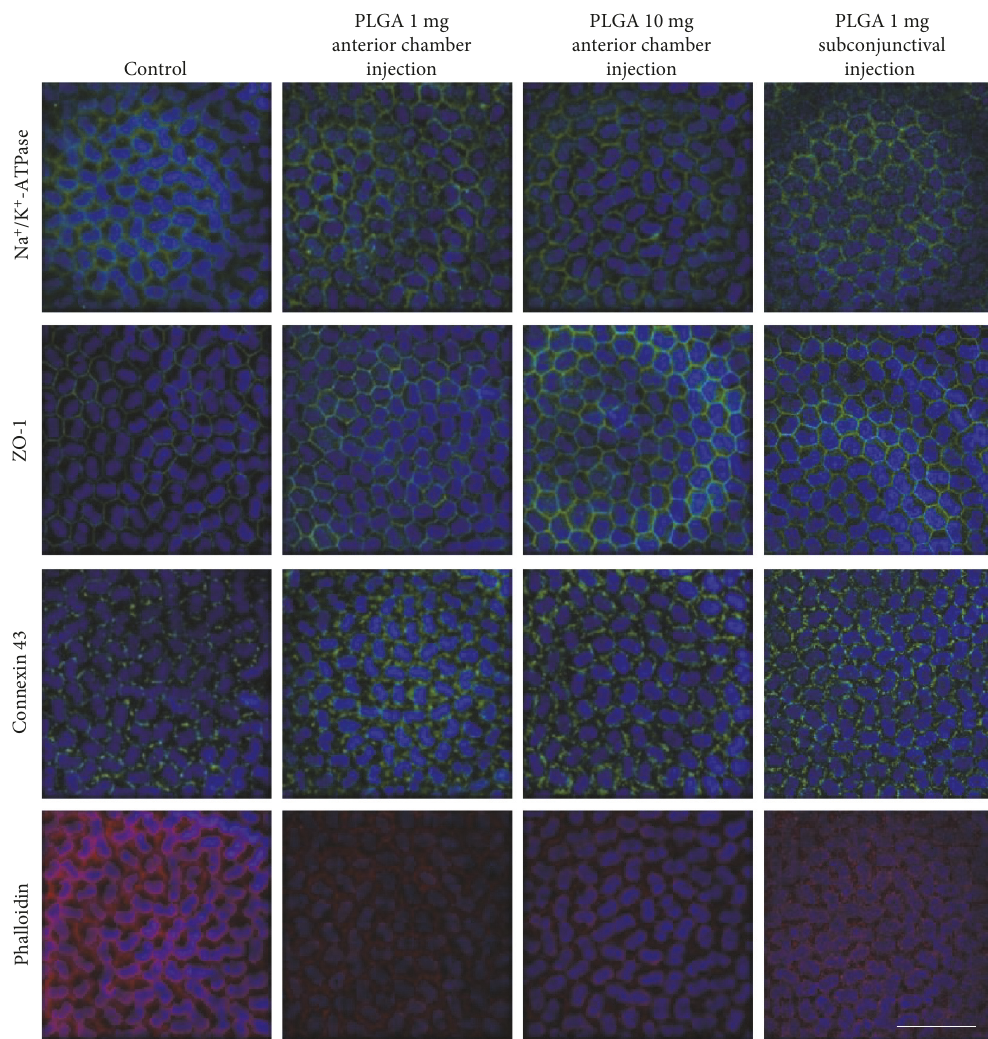
Figure 4: Histological evaluation of corneal endothelium in rabbit eyes injected with poly lactic/glycolic acid (PLGA) microspheres. One or 10mg PLGA microspheres was injected into the anterior chamber, and 1mg PLGA microspheres was injected into the subconjunctiva. After 14 days, corneal endothelium was evaluated by immuno fl uorescence staining and phalloidin staining. Na + /K + -ATPase (a marker of pump function), ZO-1 (a marker of tight junction), and connexin 43 (a marker of gap junctions) were used to evaluate the functional property of corneal endothelium. Phalloidin staining was used for morphological analysis. Nuclei were stained with DAPI. Scale bar: 50 μ